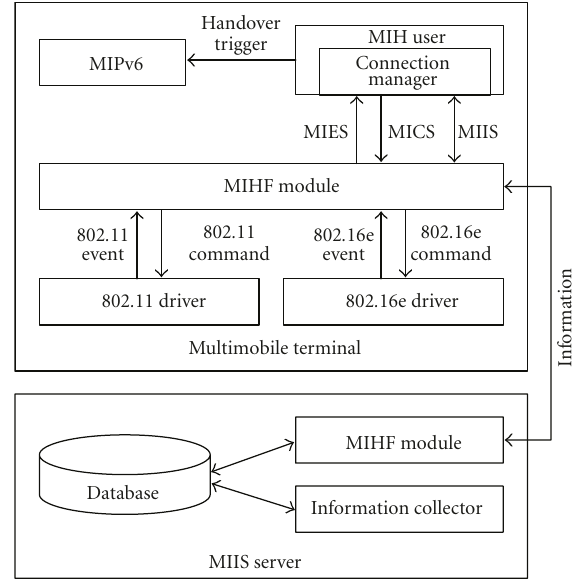
Figure 1: Overview of MIH framework.